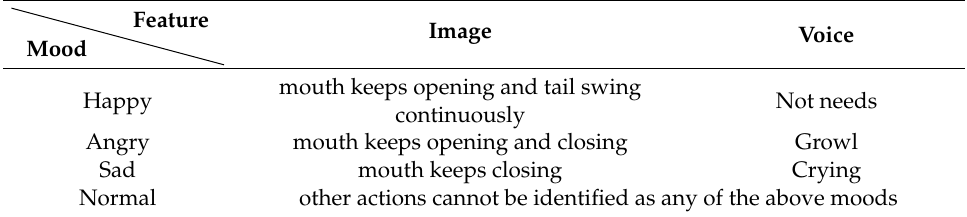
Figure 10. Continuous image combined with sound identification results. Table 1. Rules of multiple feature dependency